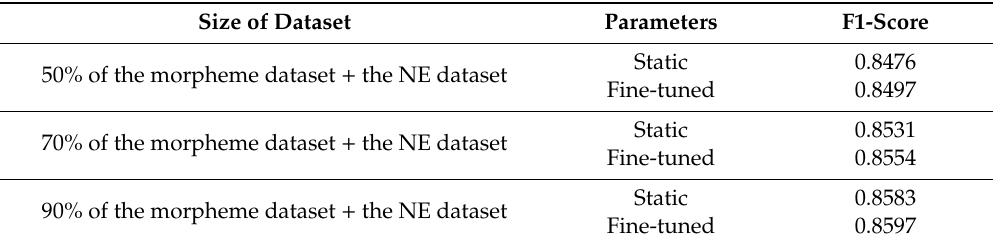
Table 8. Performances of NER according to di ff erent training data